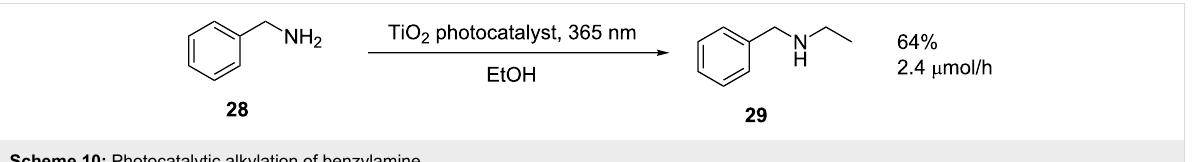
Scheme 10: Photocatalytic alkylation of